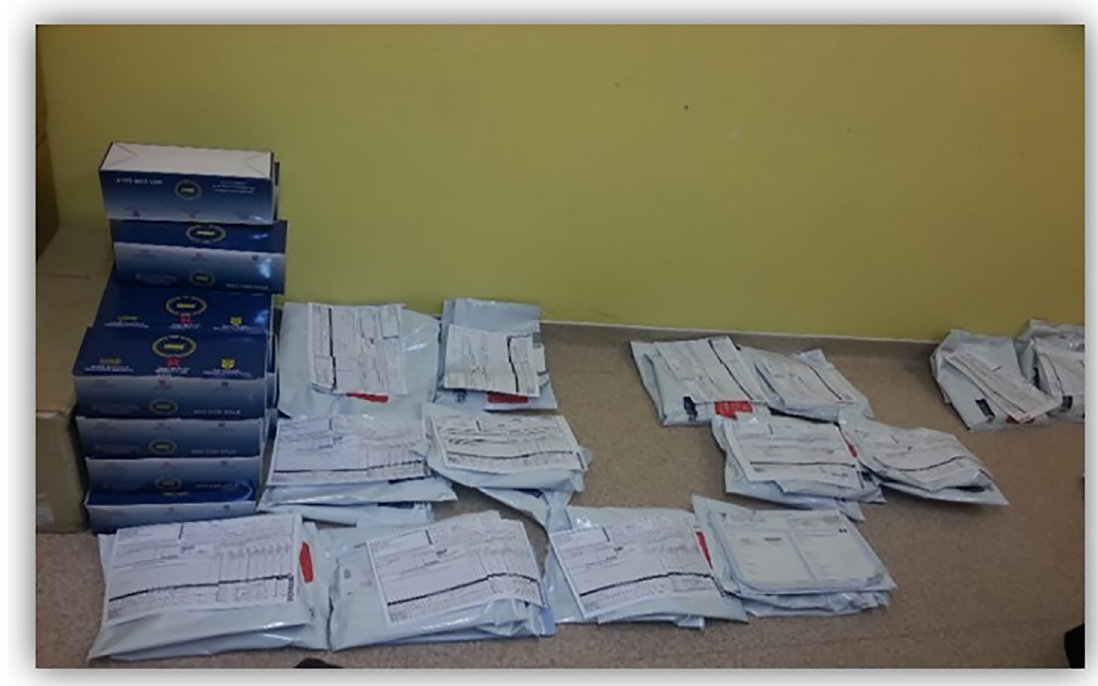
Fig 6. Organised medication packages.